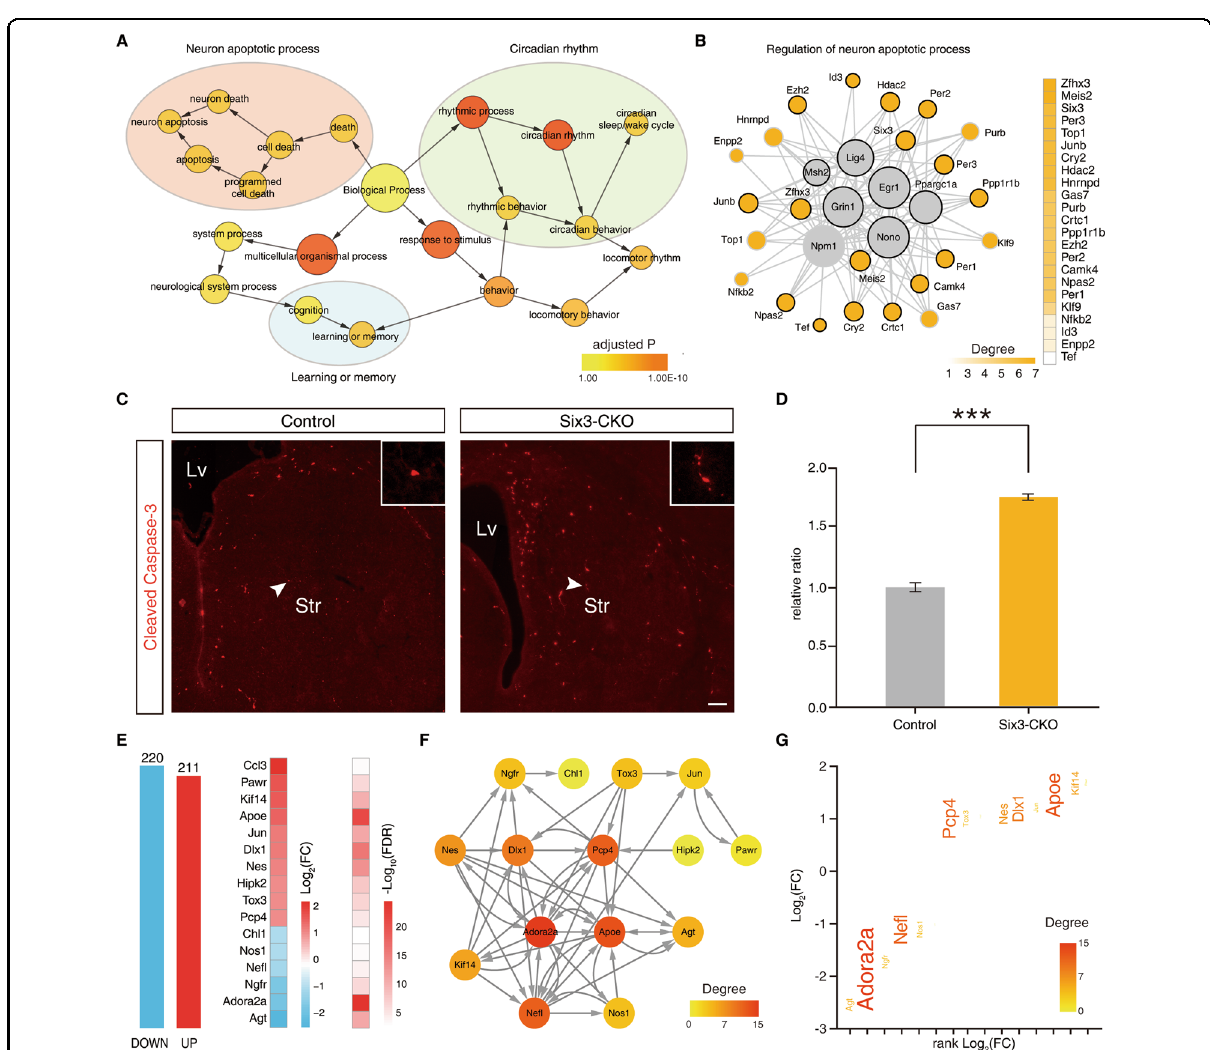
Fig. 5 Novel functions of Six3 predicted from TF networks. A Part of the BiNGO results for a TF network, as visualized in Cytoscape. Red categories are the most signi fi cantly overrepresented. Yellow nodes are not signi fi cantly overrepresented, which include orange nodes in the context of the GO hierarchy. The size of a node is proportional to the number of genes in the test network annotated to the corresponding GO category. B Topological representation of the reconstructed “ regulation of neuron apoptotic process ” TF regulatory network using ARACNE. TFs are represented as nodes and inferred interactions as edges. Gray nodes indicate the known functional TFs. Potential functional TFs are colored orange. The degree of orange nodes is shown on the right. C The expression of cleaved Caspase-3 in Six3-CKO striatum increases signi fi cantly compared to controls at P0. Scale bars: 100 μ m in c. D Histogram showing that the number of cleaved Caspase-3 + cells was increased in Six3-CKO mice. (Student ’ s t test, *** P < 0.001, n = 3 mice per group, mean ± SEM). Lv lateral ventricle. Str striatum. E Histogram of DEGs in the LGE at P0 between control and Six3-CKO mice. The 16 DEGs associated with “ regulation of neuron apoptotic process ” are shown. F A GRN of these “ regulation of neuron apoptotic process ” genes was inferred by Genie3. The edge direction represents the regulatory interaction from regulatory genes to target genes. Node size and color are proportional to the number of genes (in-degree and out-degree). G Key downstream genes that are candidates for regulating the neuron apoptotic process. The signi fi cantly changed genes in Six3-CKO mice versus wild-type mice are shown. Genes are colored by their importance (degree) in the “ regulation of neuron apoptotic process ” GRN, and the gene font size increases with its